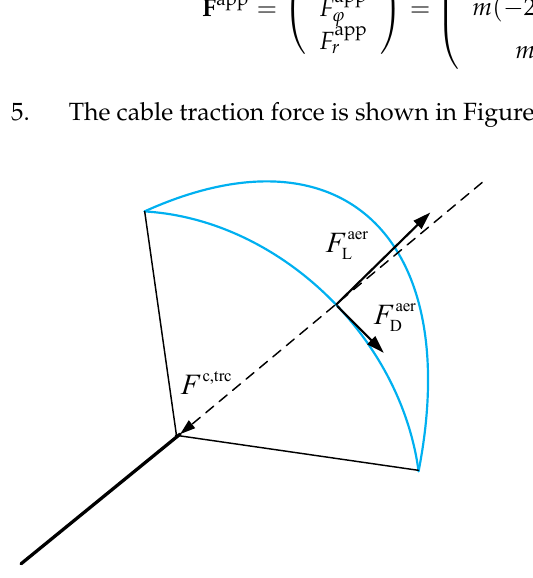
F and aer F , cable traction c,trc F on a parafoil. Figure 4. Aerodynamic forces F aer and F aer , cable traction F c,trc on a L D L D